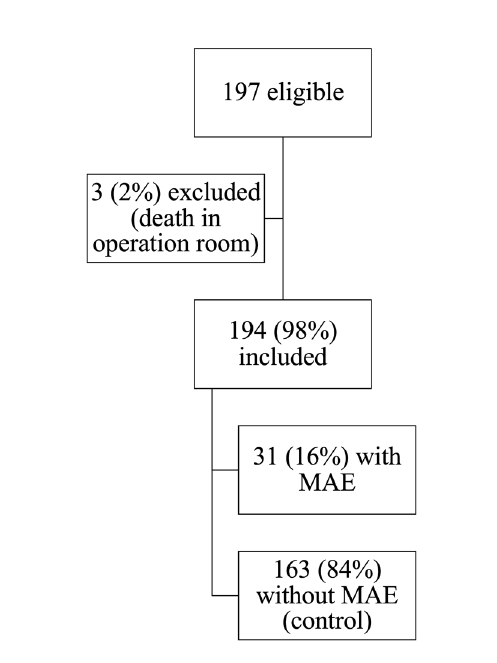
Fig. 1 - Flowchart of patient recruitment and inclusion. MAE=major adverse event.